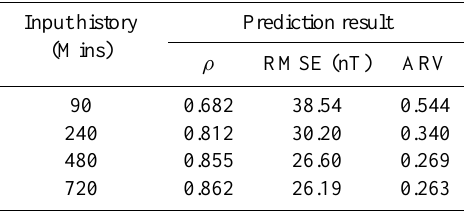
Fig. 10. Correlation plots of the SYM-H indices observed and predicted by Elman and NARX neural networks. (a) For the Elman model with input history length of 90 min; (b) For the Elman model with input history length of 720 min; (c) For NARX model with feedback time delay length of 120 min. Table 1. Storm intervals used to develop the ANN prediction model Table 4. Prediction result by Elman ANN with different length of input No.